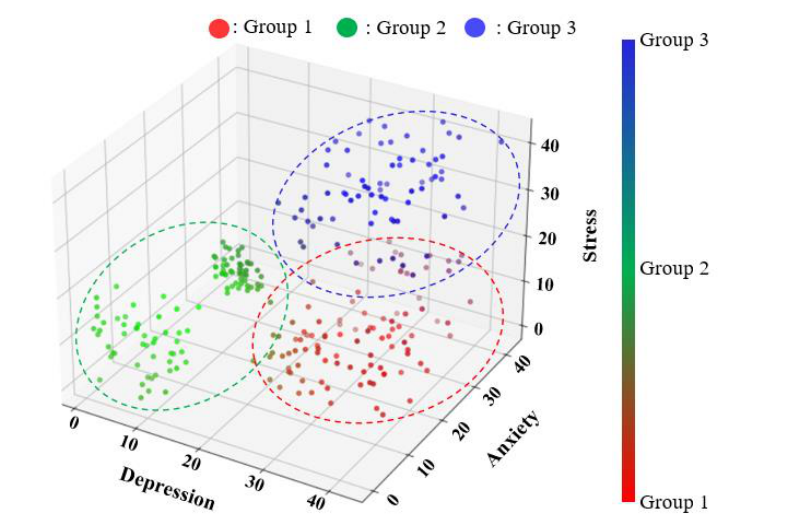
Figure 6. Visualization of fuzzy clustering for three groups using open-source DASS survey.